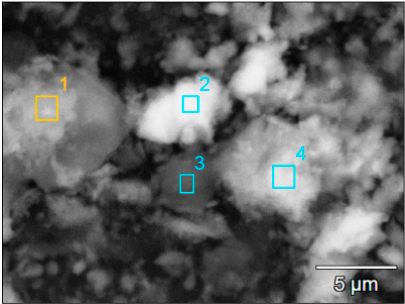
Figure 11. SEM picture of Pd/GO-TiO 2 . The content of Pd ranged from 0.01 to 0.06 atom% and The Cl content was 0.52–1.87 atom%.